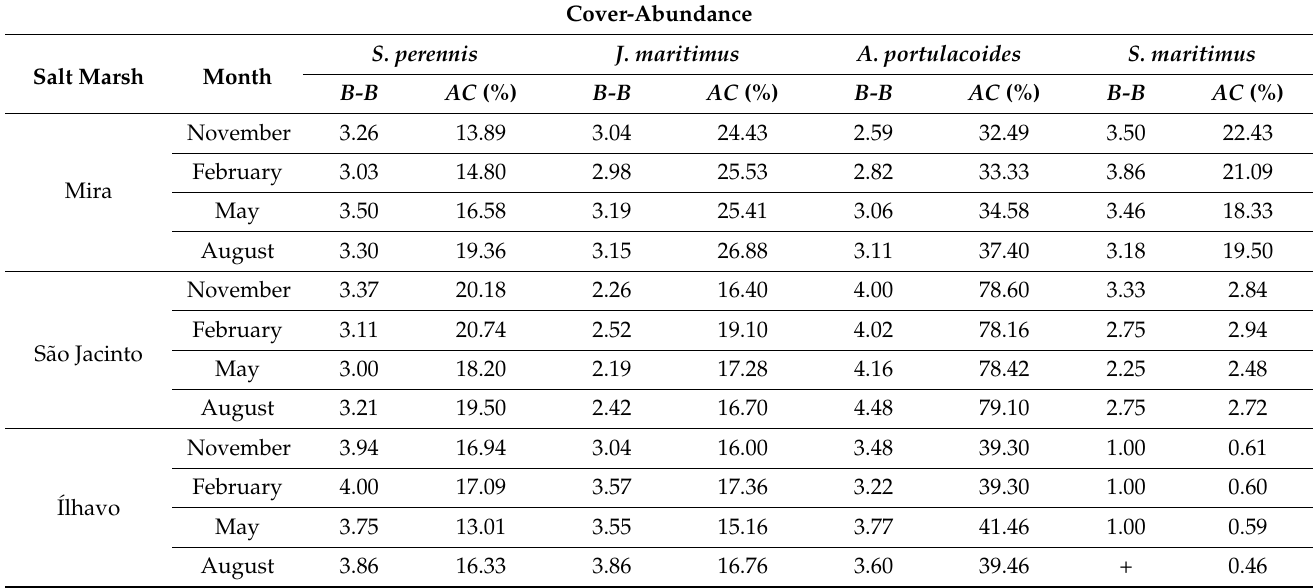
Table 2. Summary table of seasonal cover-abundance Braun-Blanquet ( B-B ) and average cover ( AC ) mean values attained by the main species. Autumn (November); winter (February); spring (May); summer (August). The symbol “+” refers to low coverage with few